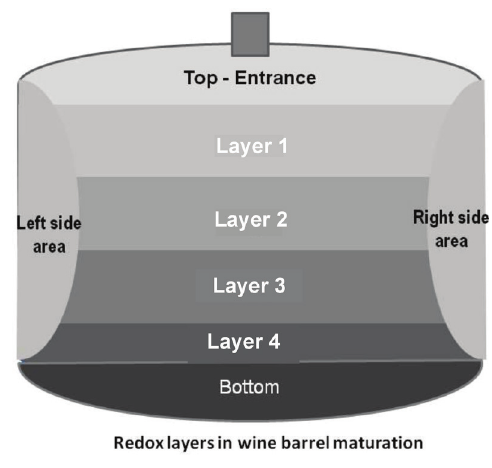
Fig. 3 – Redox layers in wine barrel